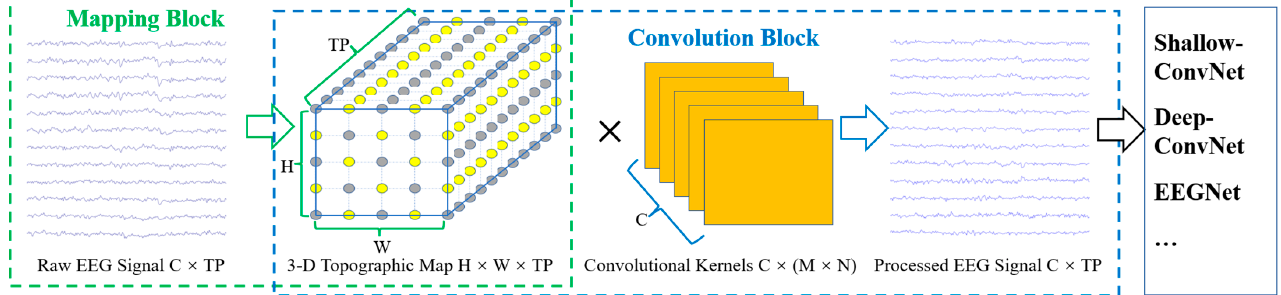
Figure 1. Overall visualization of the TRM. C: channels, TP: time points, H: height, W: width, ( M × N): kernel size. The parts framed by green and blue dashed lines are the mapping block and the convolution block, respectively. In the 3-D topographic map, the coordinates of the yellow points correspond to the electrode locations of the raw EEG signals, and the values are the potential values of the electrodes, while the gray points have no corresponding electrodes, and their values are set to 0. The outputs and inputs of the TRM possess the same size.